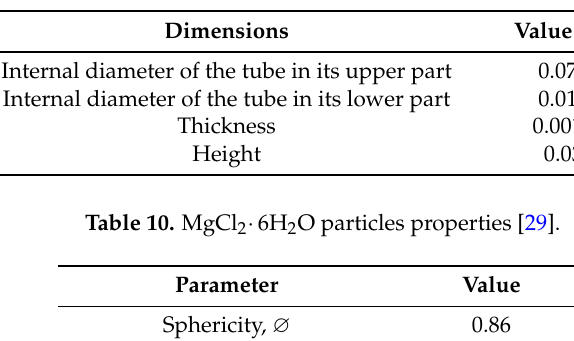
Table 9. Dimensions of the uniformization section of the fluidization chamber.